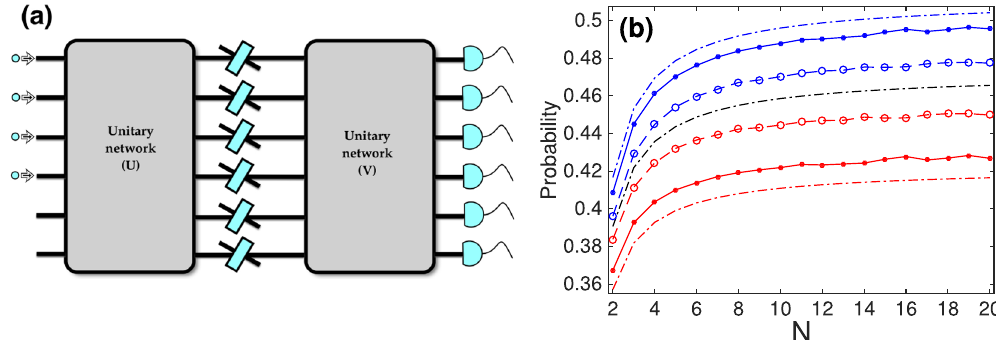
Figure 3. The survival probability in a lossy network. Panel (a): an equivalent representation of a lossy M -port linear network A = UDV with a unitary 2 M -port network, where U and V are some unitary M -ports and the diagonal matrix η η = … D diag( , , ) corresponds to M beamsplitters (with the transmission coefficients M 1 … , η η 1 , M ) placed between them. Panel (b): the average survival probability of N indistinguishable bosons (above the middle dash-dot line) and fermions (below the middle dash-dot line) in a random 4 N -port network with m = 3 lossy channels having the loss rates η 1,2,3 = 0.1 (dots on the solid lines) and η 1,2,3 = 0.3 (open circles on the dashed lines). The dash-dot lines give the analytical average survival probability of Eq. (13) for m = 3 completely lossy channels η 1,2,3 = 0, where from top the to bottom we have bosons, distinguishable particles, and fermions, respectively. The averages are computed over 9000 random unitary matrices U